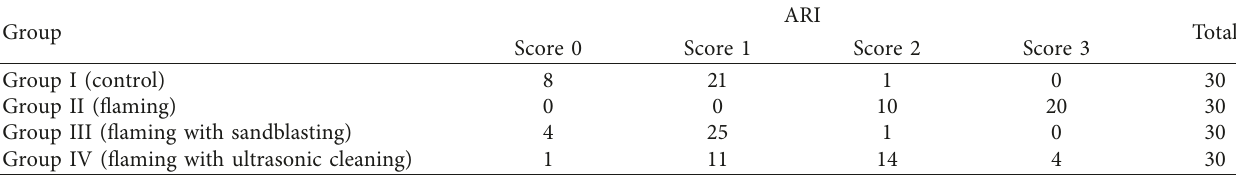
Table 4: Adhesive remnant index (ARI) scores for different groups.